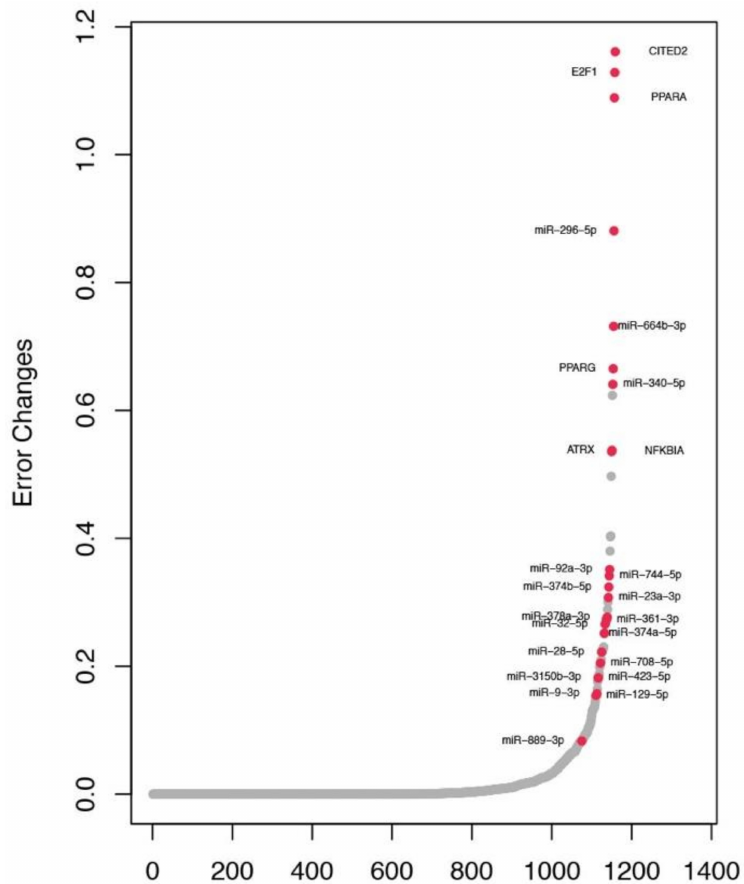
Figure 4. Error changes caused by regulators of the TN subtype. The x-axis indicates the miRNA/TF regulators, and the y-axis indicates increase in squared error across samples of the TN subtype after excluding the regulator from regression models. All regulators are ranked based on increase in squared error, and 24 key regulators (red dots) for the TN subtype were identified with FDR <